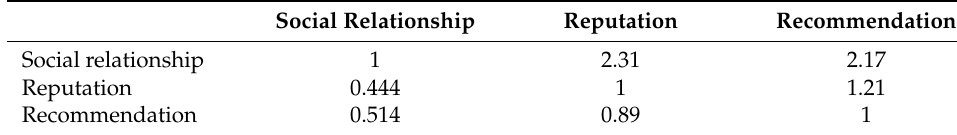
Table 11. Fuzzified crisp matrix for scenario 2.